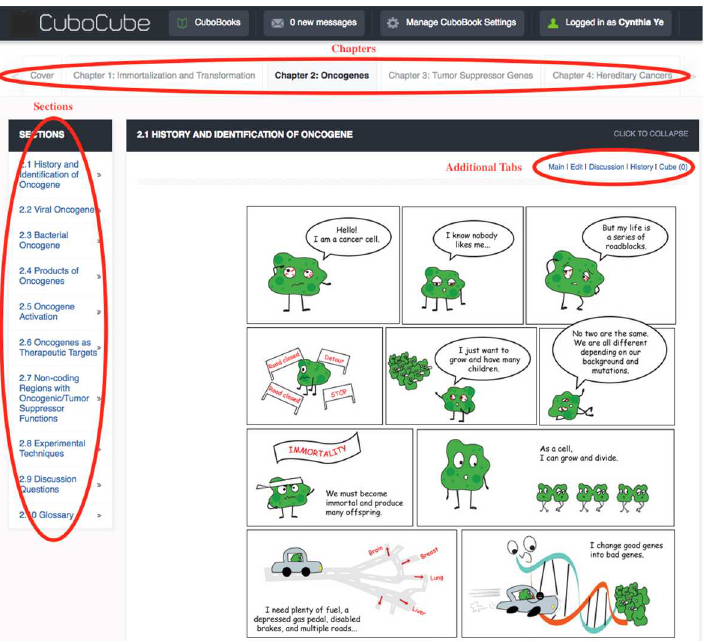
Fig 1. Readerinterface of a CuboCube site. Screenshot of a page from the Cancer Genetics E-textbook. A reader can navigatethrough chapters by using tabs on top of the page and navigatethrough sections within a chapter using tabs on the left of the